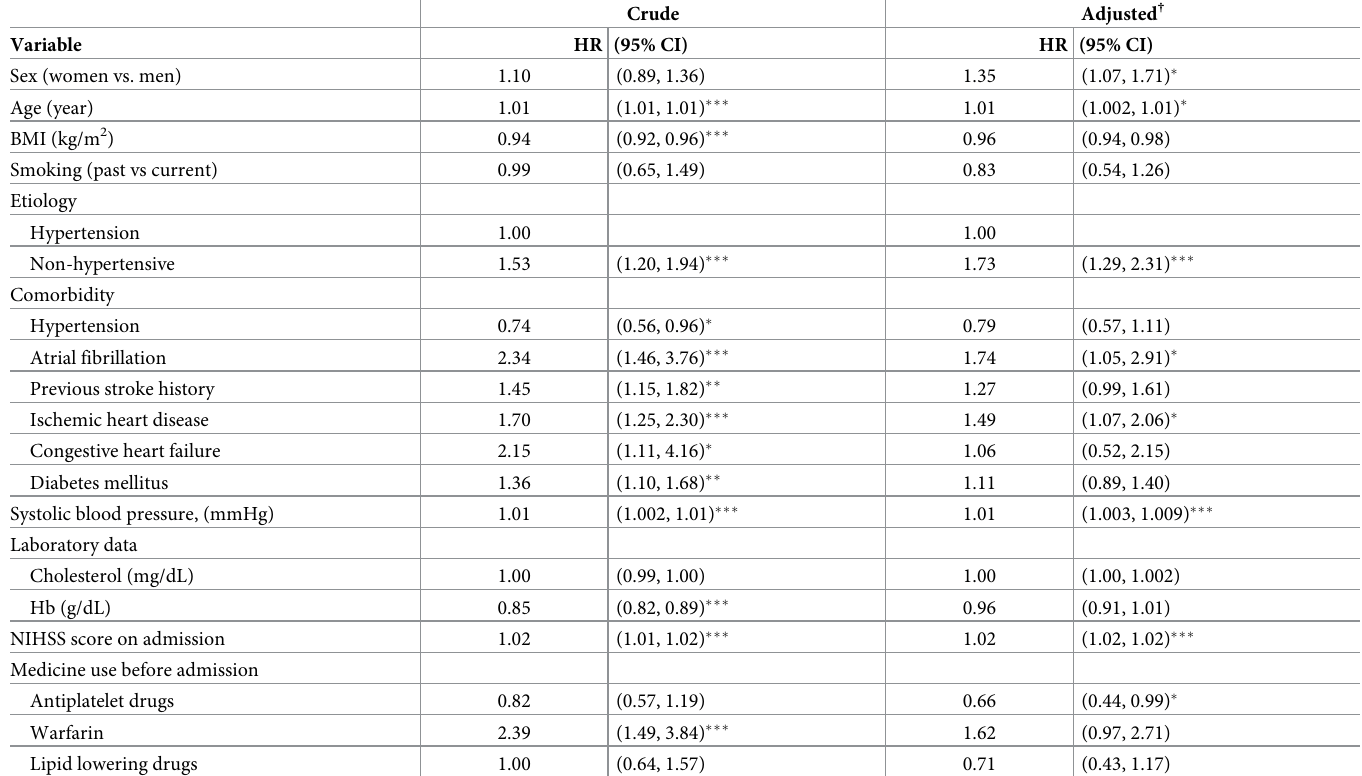
Table 5. Hazard ratios for mortality at 1 year after intracerebral